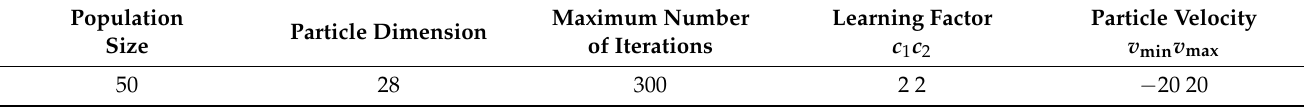
Table 4. IPSOARW parameter selection.